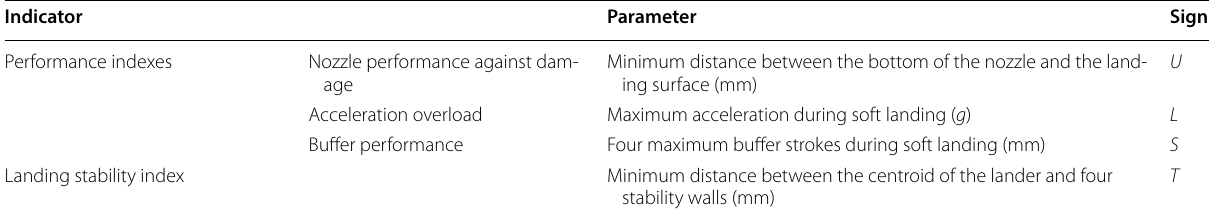
Table 2 Initial buffer characteristic parameters